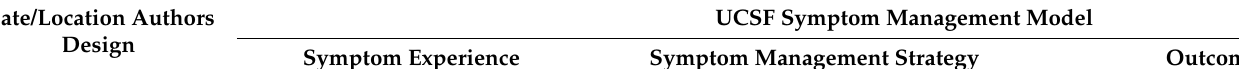
Table 2. Nurse-led Symptom Science Studies on Improving Sleep Disturbances in